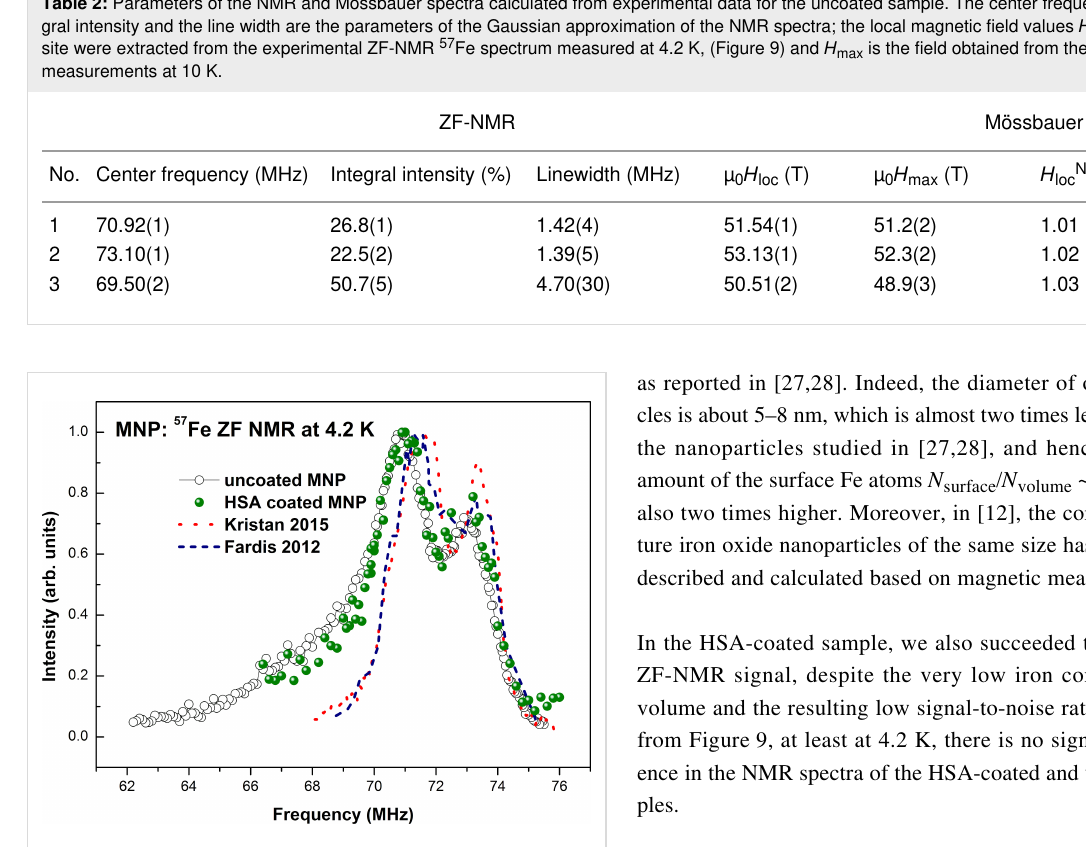
Figure 9: Experimental ZF-NMR spectrum of 57 Fe nuclei measured at 4.2 K in our metal nanoparticles (MNPs). Open circles and green spheres correspond to our samples of the uncoated and HSA-coated nanoparticles, respectively. The blue dashed line is the spectrum of maghemite nanoparticles adopted from [27]; the red dashed line is the spectrum of maghemite nanoparticles adopted from [28].